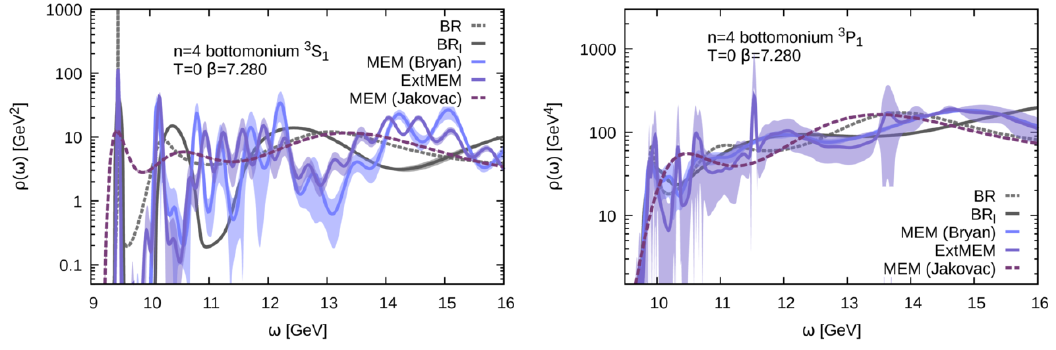
Figure 29 . Representative examples of the methods dependence of the bottomonium spectral reconstructions at zero temperatures ( (cid:12) = 7 : 280). We depict the S-wave channel in the top row, the P-wave channel in the bottom row. There are (cid:12)ve di(cid:11)erent methods compiled here: two versions of the BR method, the standard one as light gray dashed line and the smooth BR method as dark gray solid line. They are contrasted to three di(cid:11)erent MEM realizations, the Bryan implementation (light blue solid), the extended MEM with additional 32 basis functions (darker blue solid) as well as the Jakovac MEM as dark violet dashed line.